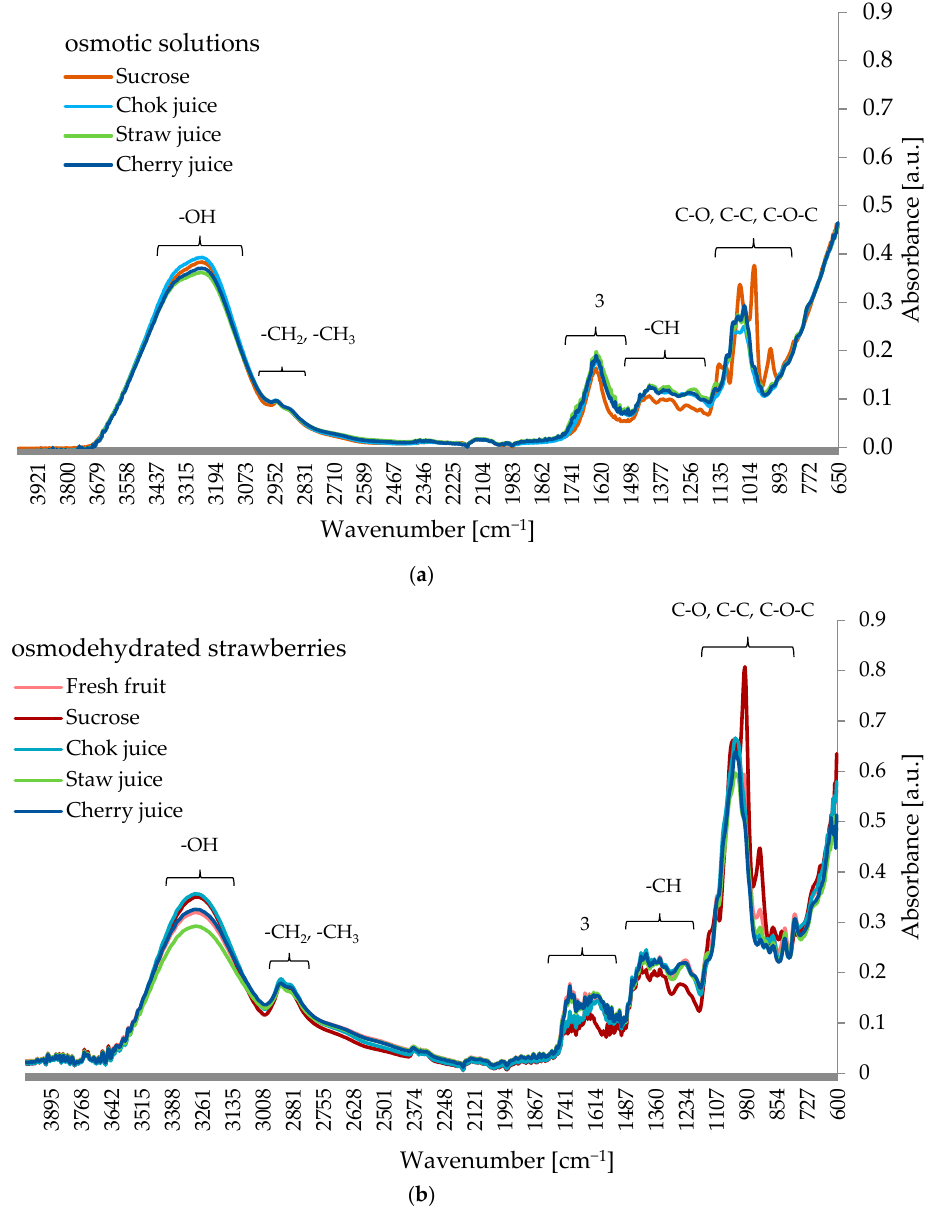
Figure 8. Fourier transform infrared (FTIR) spectra of the solutions ( a ) and strawberries after osmotic dehydration ( b ) conducted in a different type of osmotic agent (sucrose and fruit concentrates).